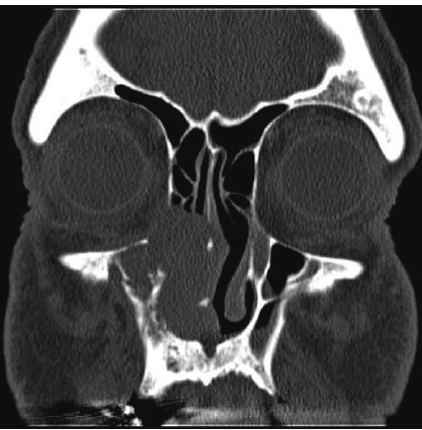
Figure 1: Coronal CT of the sinuses reveals right nasal maxillary mass with medial orbital wall destruction.